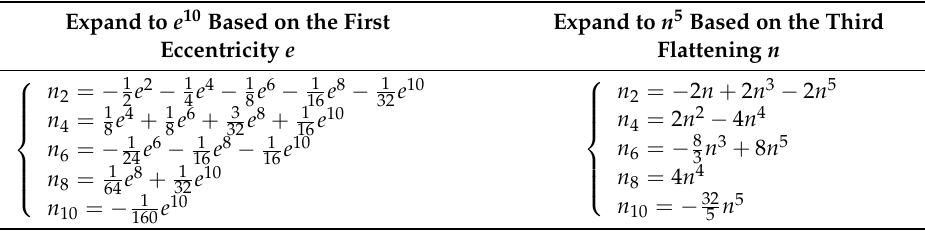
Table 5. Coefficients in Equation